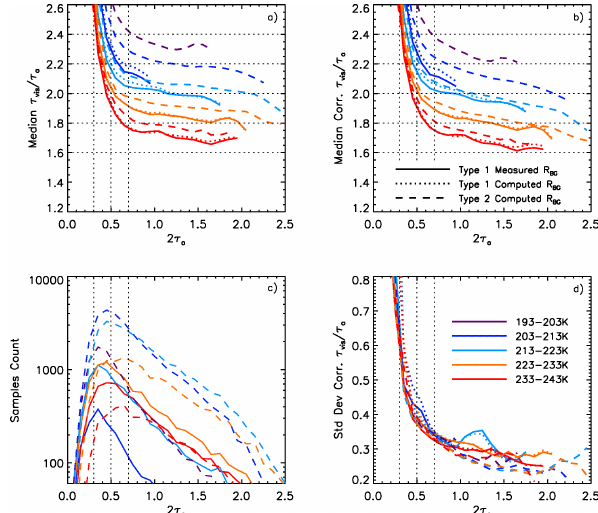
Figure 5. Median τ vis / τ a ratio against 2 τ a (a) from IIR standard products and (b) after correction for cloud radiative temperature, (c) sample count, and (d) τ vis / τ a ratio standard deviation. Type 1 clouds: measured R BG available and τ a either from measured R BG (solid) or from computed R BG (dotted); type 2 clouds: no measured R BG available and R BG from computations (dashed). Colors are for temperature at centroid altitude T c in 193–203K (purple), 203– 213K (navy blue), 213–223K (light blue), 223–233K (orange), and 233–243K (red). The vertical dotted lines highlight the results for 2 τ a between 0.3 and 0.7 (see text). Data set: single-layered cir- rus randomly oriented ice with high confidence, base temperature < − 20 ◦ C, over ocean, 25 ◦ S–25 ◦ N,